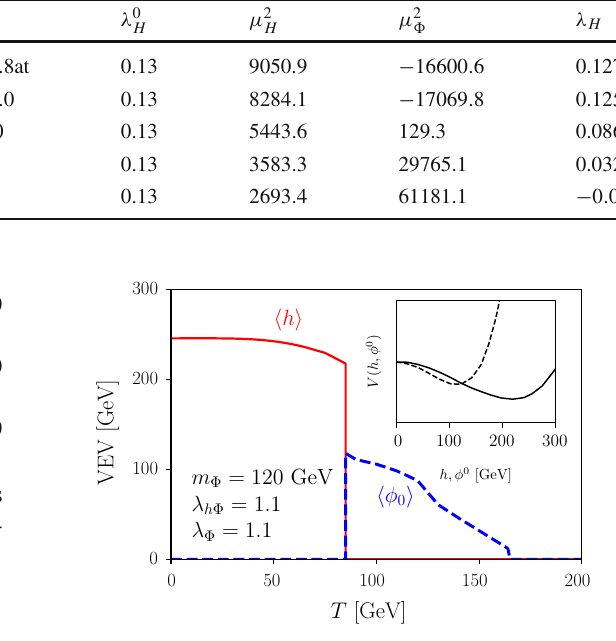
Fig. 3 Evolution of the VEV with the temperature for the parameter space point m (cid:2) = 120 GeV, λ h (cid:2) = 1 . 1, λ (cid:2) = 1 . 1. At high tem- peratures, the EW symmetry is restored. It is spontaneously broken to ( (cid:11) h (cid:12) , (cid:11) φ (cid:12) ) ∼ ( 0 , 10 ) GeV at T ∼ 160 GeV, evolving until T 0 GeV at which the step ( 0 , 120 ) → ( 220 , 0 ) GeV takes place. This latter transition is clearly strong; (cid:11) h (cid:12) / T n > 1. The shape of the potential at